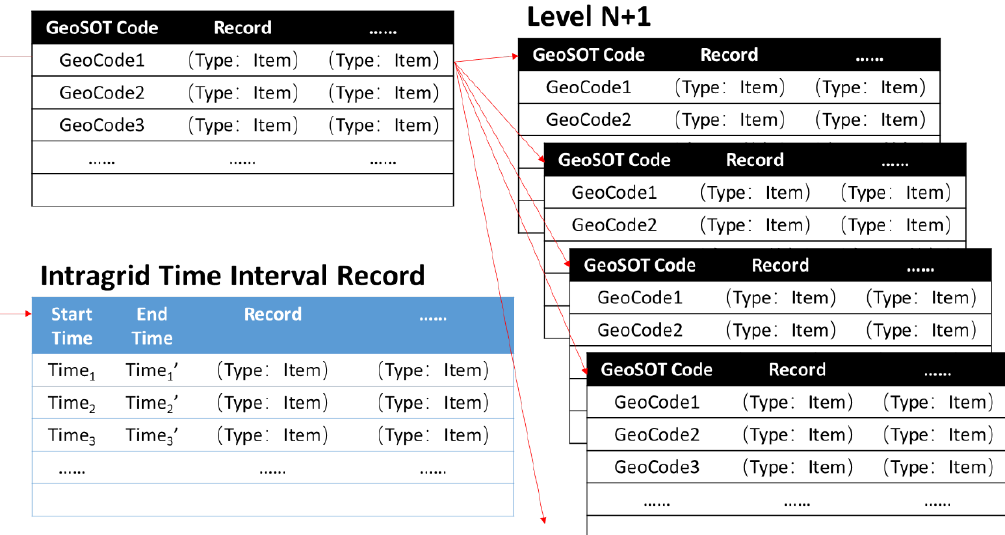
Figure 3. Multitable strategy. There are a number of data tables in the nonrelational database. Each data table records spatiotemporal data at a specific subdivision level. Records at higher levels preserve pointers to the data table at lower levels. The GeoSOT-3D grid code is set as the primary key for each table. Temporal information is also recorded corresponding to each GeoSOT-3D code.